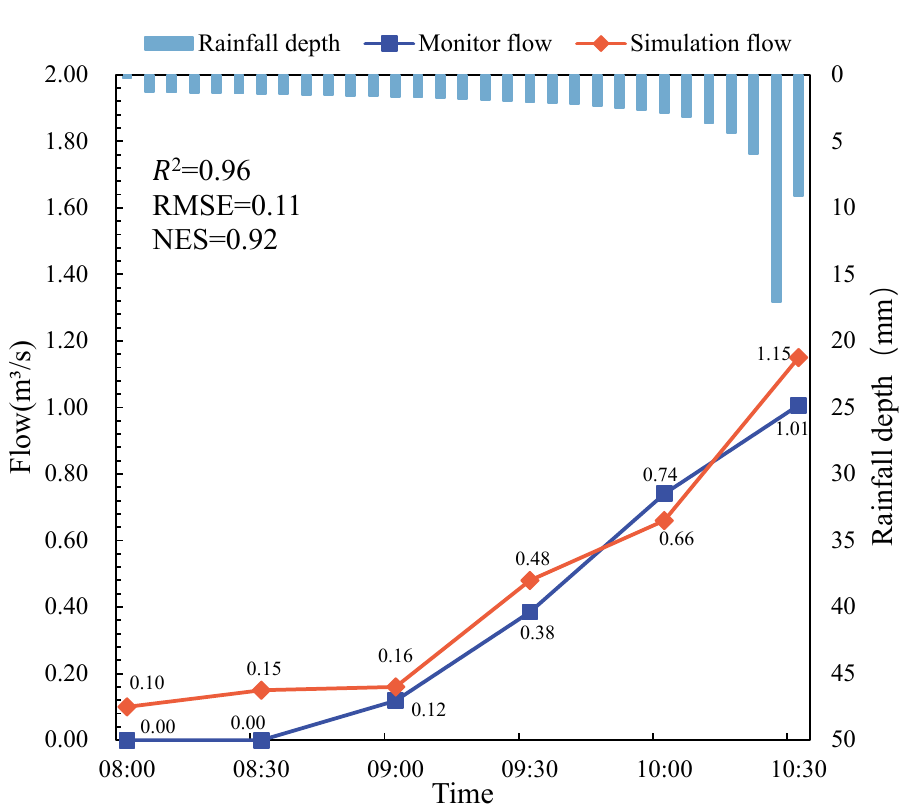
Figure 8. Process line of simulated and observed values on 12 July 2021.